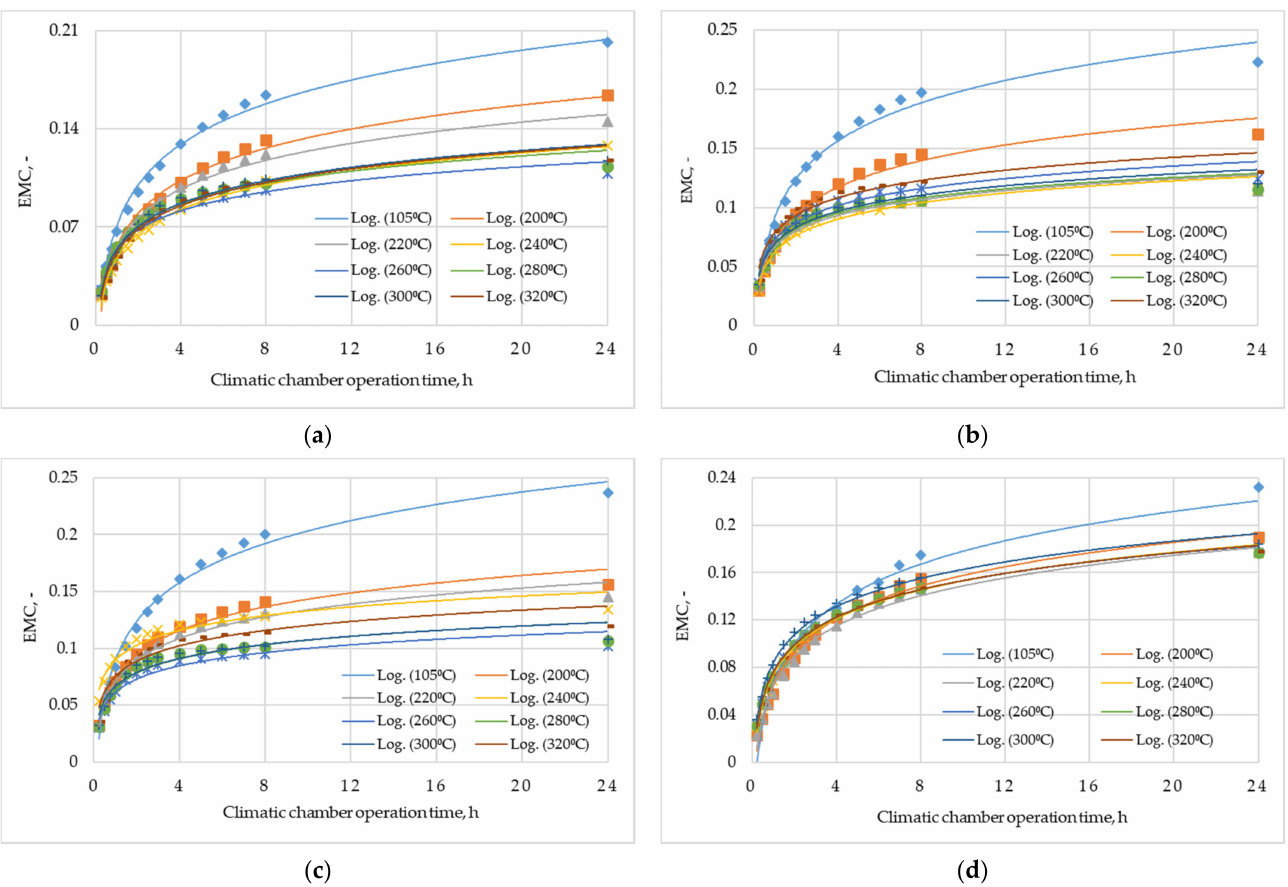
Figure 6. Kinetics of the EMC coefficient increase (logarithmic trend lines) as a function of the climatic chamber operation time: ( a ) lemon peel, ( b ) grapefruit peel, ( c ) mandarin peel, and ( d ) butternut-squash